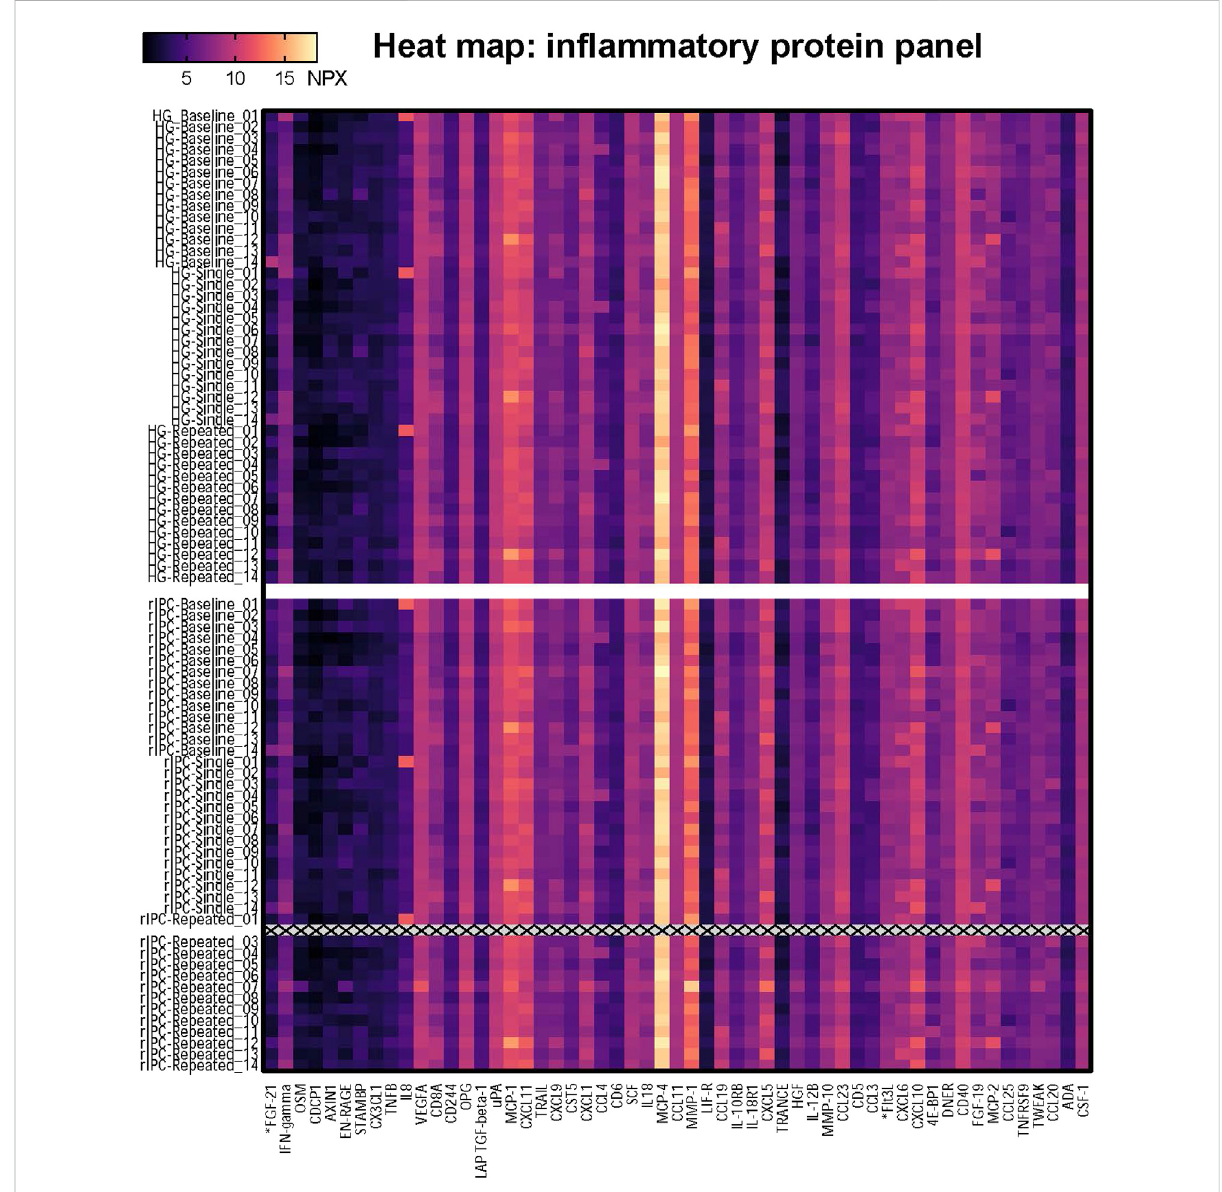
FIGURE 2 Heatmap of the proteomics analysis. The heatmap shows the NPX value for the 55 proteins in each individual sample; 14 participants who underwent two conditionings (Handgrip and rIPC) on three timepoints (baseline, single, repeated). HG = Handgrip; rIPC = Remote ischemic